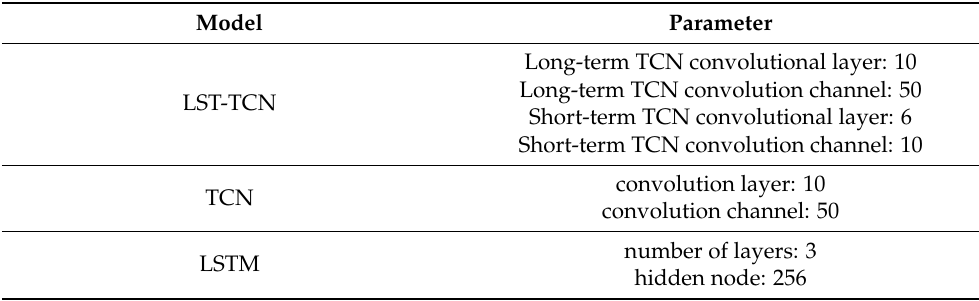
Table 1. Model hyperparameter